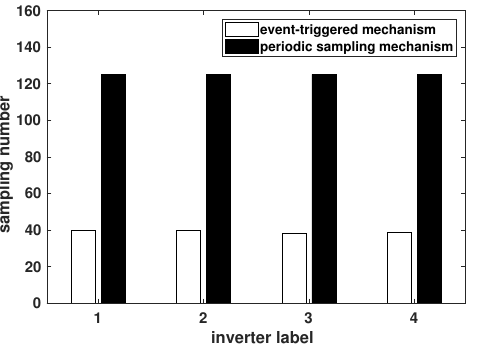
Figure 9. Sampling number comparison between event-triggered and periodic sampling mechanisms in Case